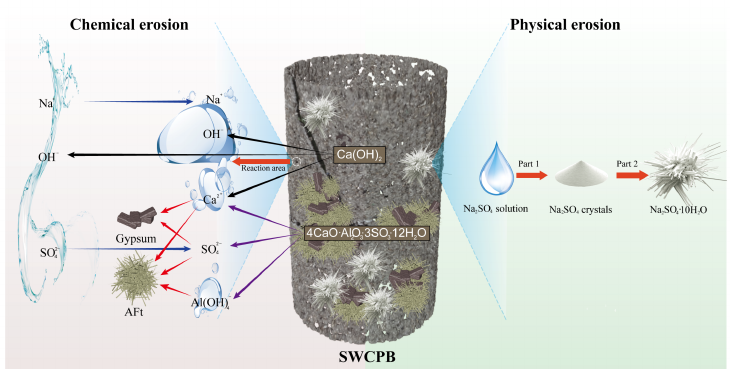
Figure 14. Schematic diagrams of the erosion